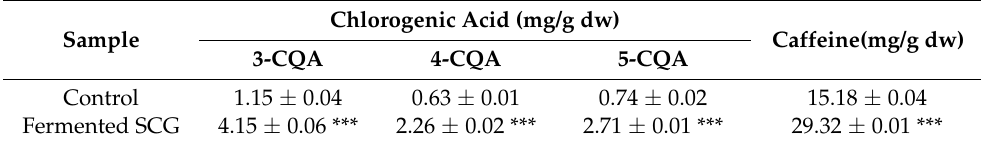
Table 3. Caffeoylquinic acid (CQA) contents in fermented SCG after 8 days of submerged